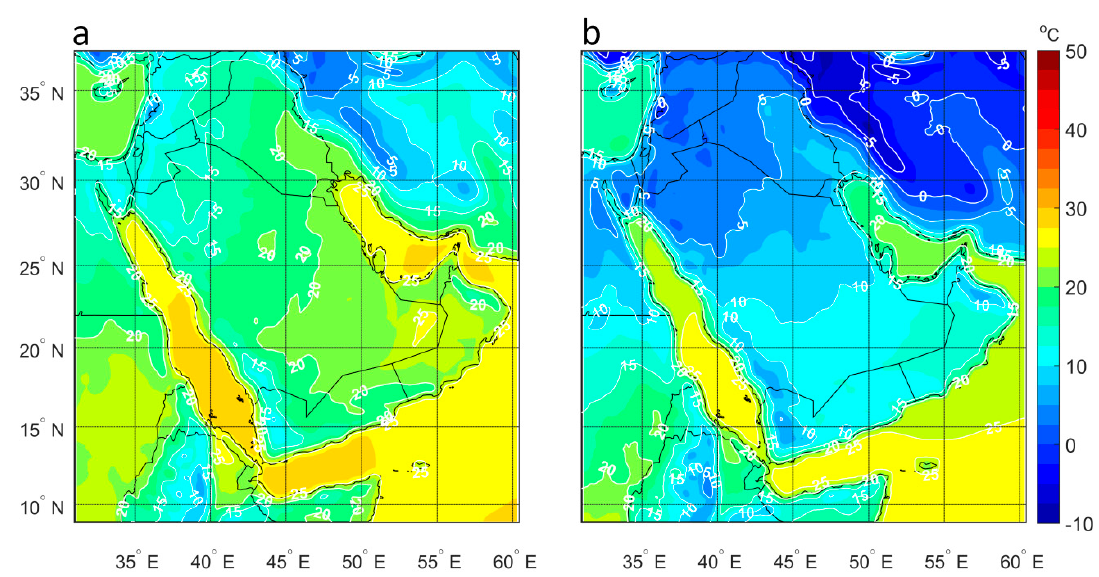
Figure 8. Annual mean of daily minimum temperature ( a ) and mean daily minimum temperature in January ( b ).